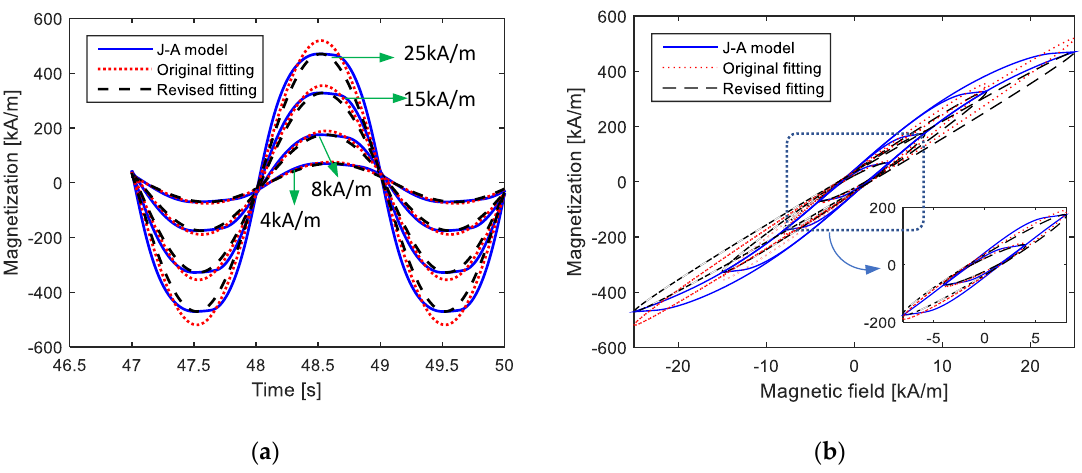
Figure 7. Comparisons of calculated magnetization curves from Jiles – Atherton model, the 1st LTI system model with parameters from directly fitting and the 1st LTI system model with parameters from fitting and extracting (under fixed parameters of k = 2 kA/m, a = 12 kA/m, c = 0.2, α = − 0.001 and M s = 80 kA/m during different amplitudes of magnetic field intensity): ( a ) time − domain curves; ( b ) M − H curves.